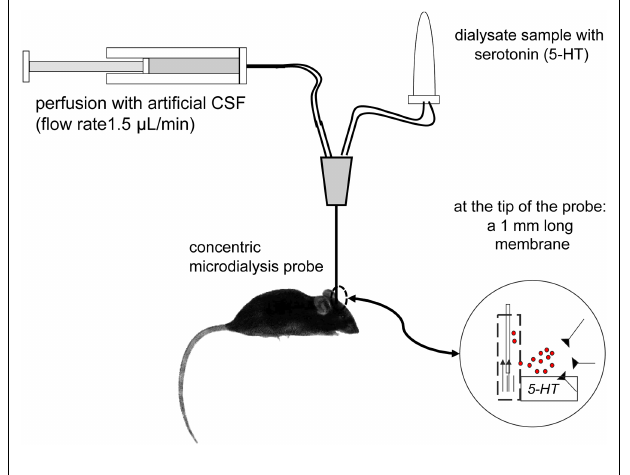
FIGURE 1 | Principle of intracerebral microdialysis in awake, freely moving